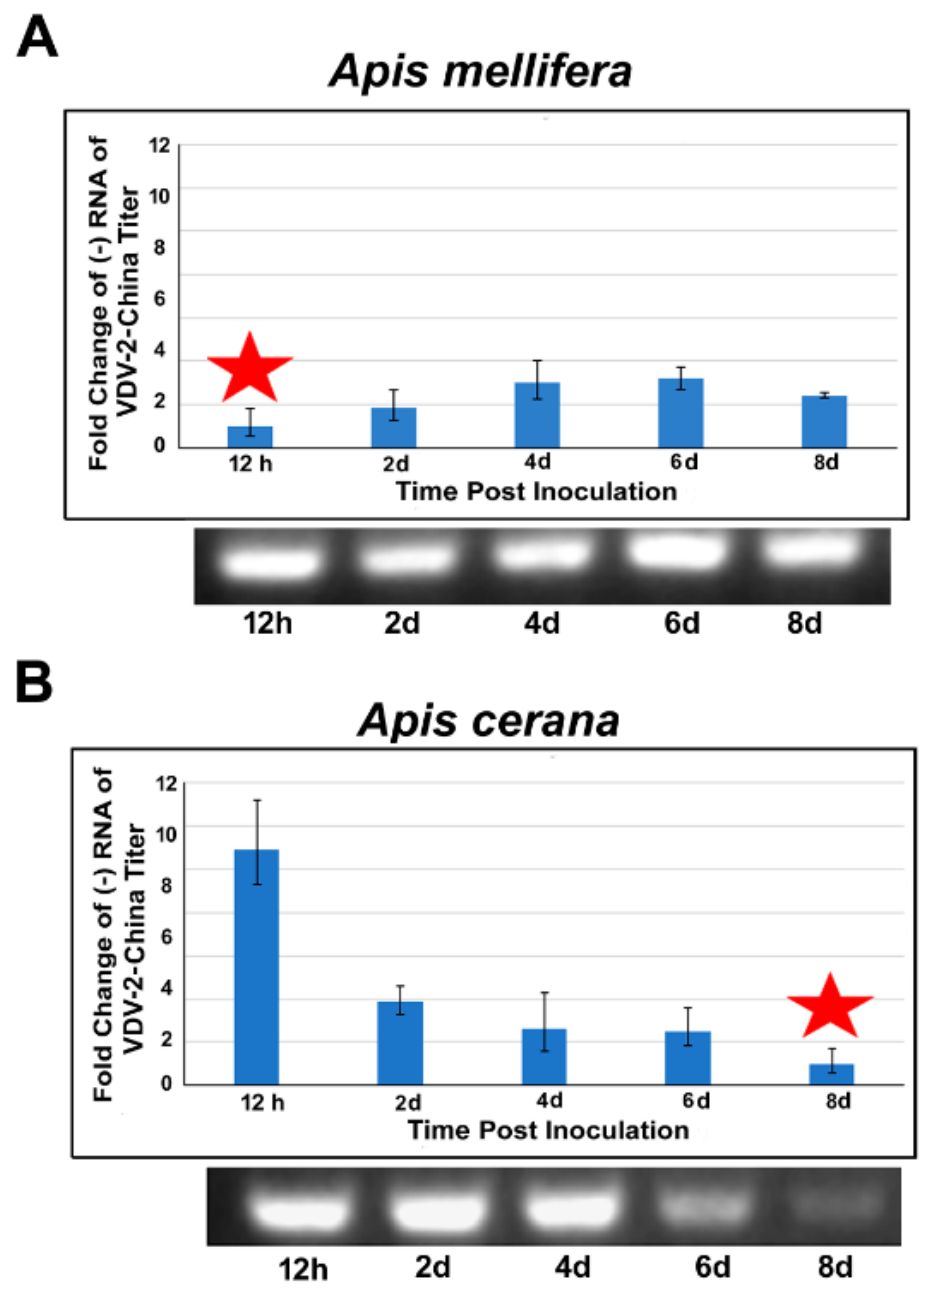
Figure 5. Fold change of the negative strand RNA of VDV-2-China titer in A. mellifera ( A ) and A. cerana ( B ) at different time points post inoculation. The fold change was expressed as an n-fold difference relative to the calibrator that had the lowest concentration and is equal to 1 (marked by a star) by the 2 – ∆∆ Ct method. The error bars on the barplot represent range of fold change in VDV-2-China titer (2 − ∆∆ Ct − S –2 − ∆∆ Ct+S ) where S is the standard deviation of the ∆∆ Ct value. The different lowercase letters above the bars indicate the statistically significant difference ( p ≤ 0.05, one-way analysis of variance (ANOVA) and Tukey’s honestly significant difference (HSD) test) among different time points post inoculation. A representative gel image of the PCR products of strand-specific RNA of VDV 2-China amplified by tagged RT-PCR at each time points post inoculation is shown below the bar chart for both A. mellifera and A. cerana